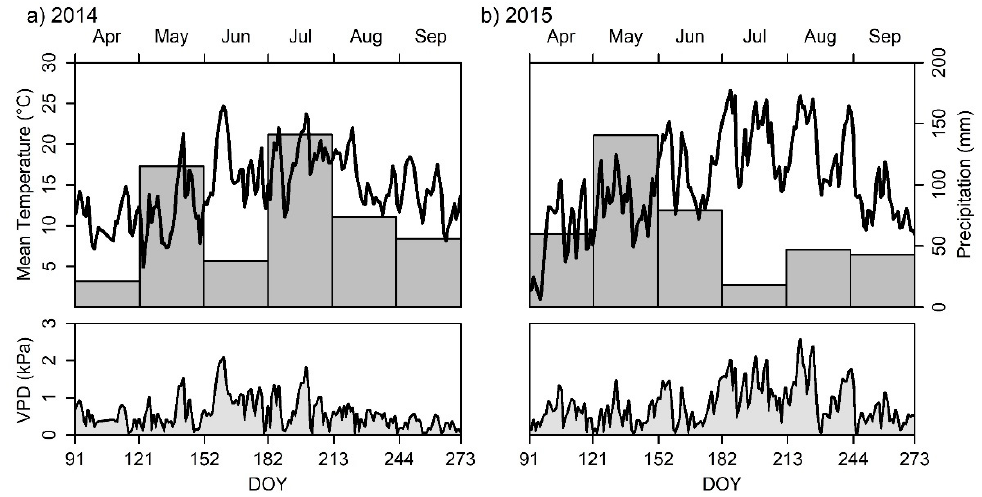
Figure 2. Monthly precipitation sums and daily mean temperature values ( a , b , above) and daily vapor pressure deficit (VPD) ( a , b , below) in the growing season (April–September) of the years 2014 and 2015.